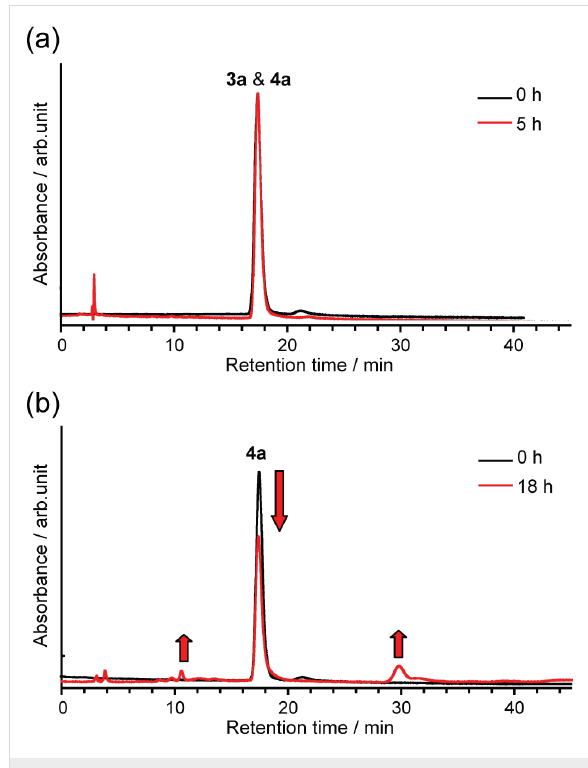
Figure 6: HPLC profiles of the mixture of 3a and 4a , (a) after heating in refluxing 1,2-dichlorobenzene and (b) after heating at 250 °C. Condi- tions: column, Buckyprep (Ø 4.6 mm × 250 mm); eluent, toluene; flow rate, 1.0 mL/min; wavelength, 330 nm;